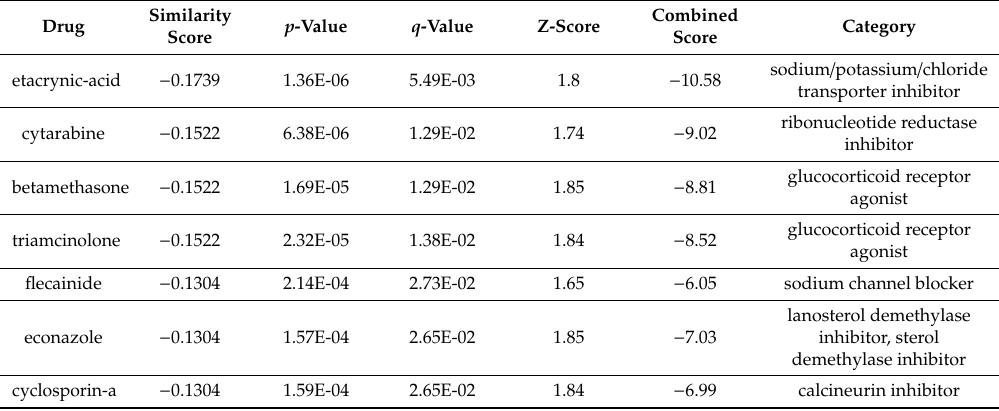
Table 2. List of biomarkers identified by DAM analysis in iPSC-derived neuronal cells 1 .